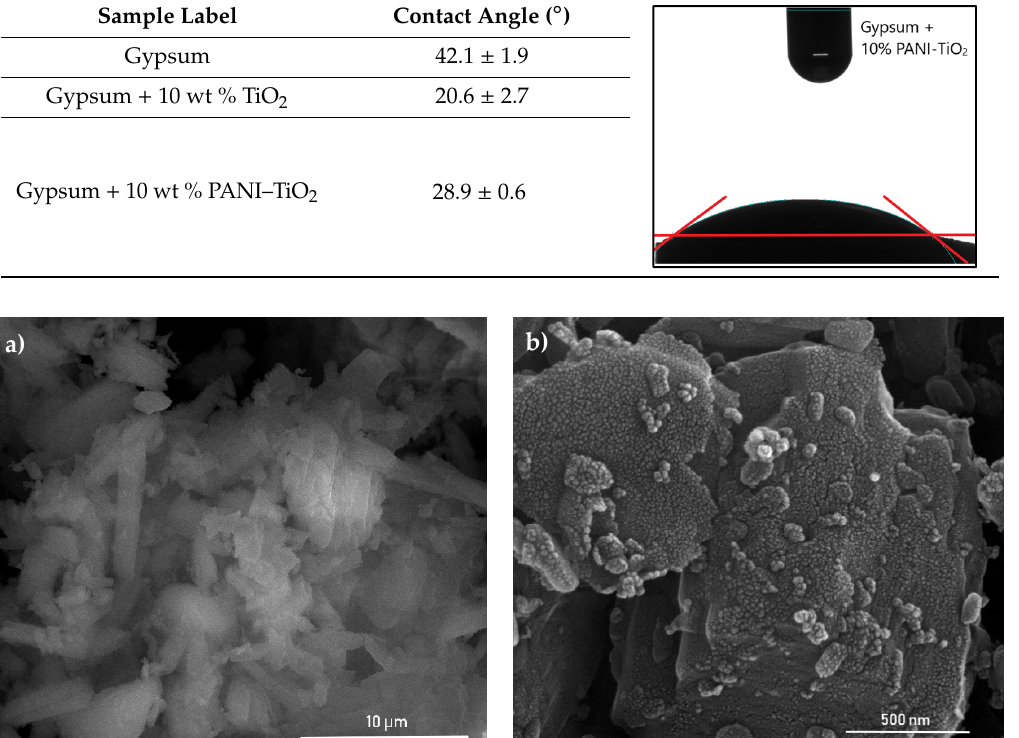
2 or PANI–TiO 2. Table 3. The contact angle analysis for gypsum and gypsum modified with TiO